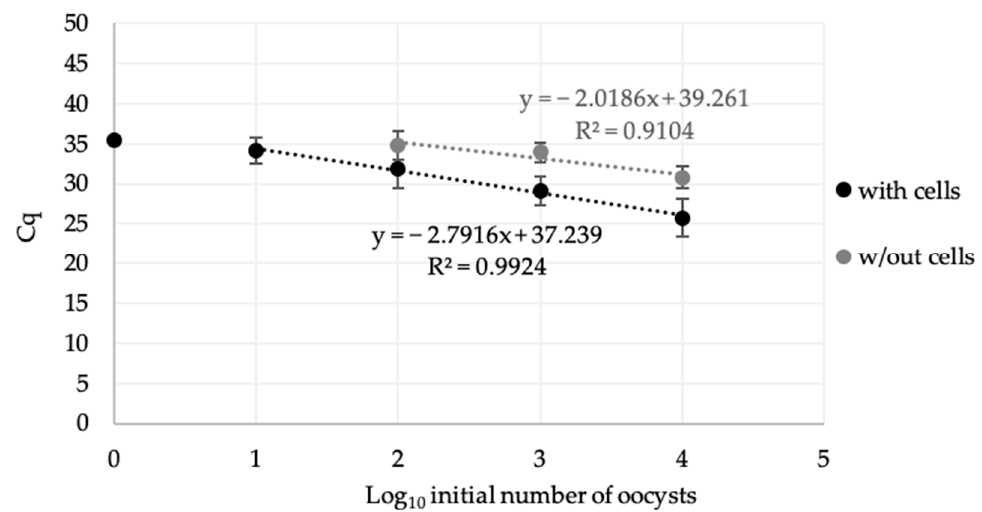
Figure 3. Standard curves of C. parvum DNA resulting from CC–qPCR after inoculation of oocysts recovered from lamb’s lettuce onto wells with (black) or without (grey) HCT-8 cells.